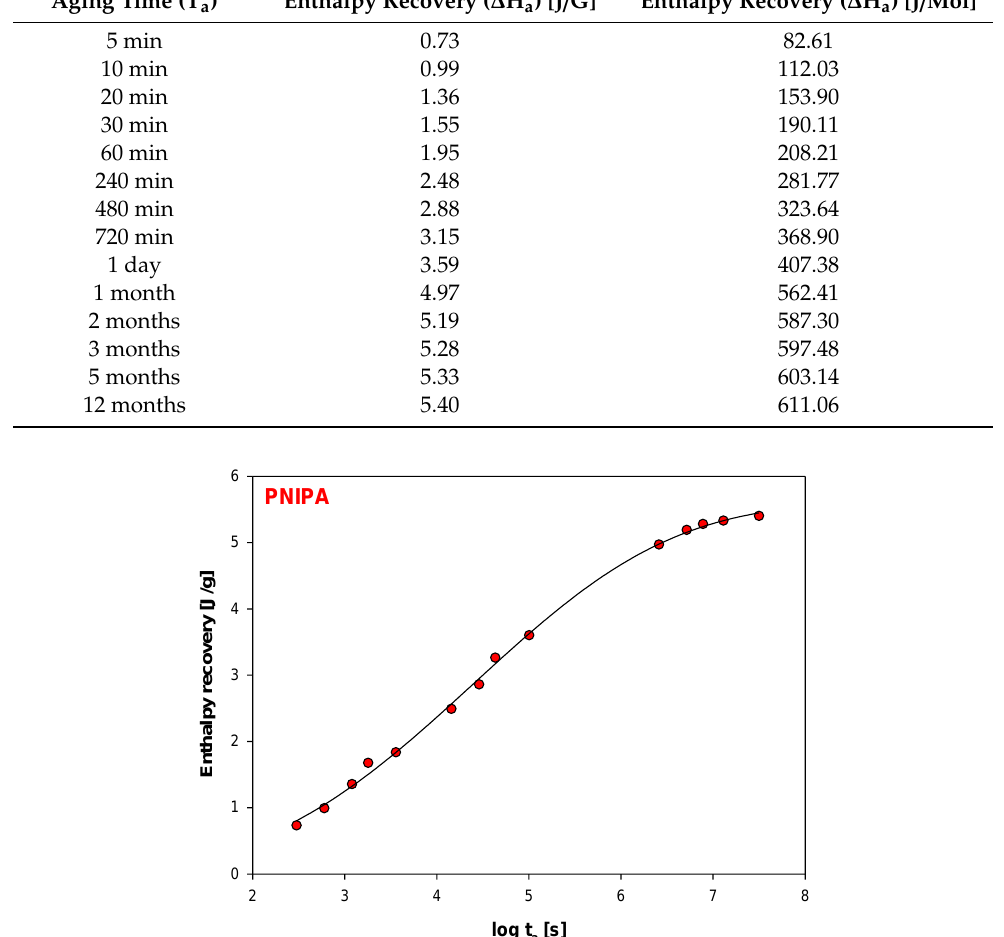
Figure 8. Changes of enthalpy recovery versus logarithmic function of aging time (R 2 = 0.9984).